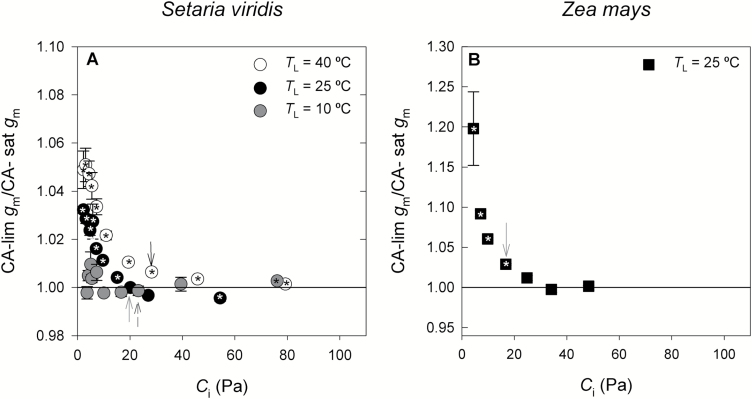
The ratio of carbonic anhydrase-limited mesophyll conductance (CA-lim gm) to CA-saturated gm (CA-sat gm) at different pCO2 inside the leaf (Ci) in (A) Setaria viridis (circles) and (B) Zea mays (squares). Setaria was measured at three leaf temperatures (TL): 40, 25, and 10 °C, as indicated in the key. Zea was measured at TL=25 °C. Values are means ±SE; n=4 in Setaria and n=3 in Zea. An asterisk inside a symbol indicates CA-lim gm/CA-sat gm ≠ 1 with P<0.05. The arrows indicate the values at ambient pCO2 and at 40 °C (black arrow), 25 °C (grey arrow), and 10 °C (dashed arrow).